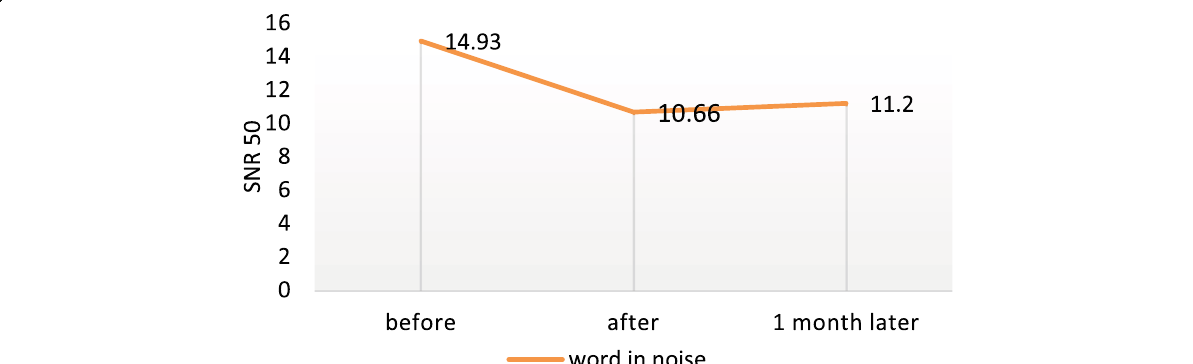
Fig. 3 The results of the repeated measures test showed that the mean score of “ Word in noise ” had a statistically significant difference in three measurements ( P .value < 0.05). The Tukey test showed that there was a statistically significant difference between the first score and the second score ( P .value < 0.05), while there is no statistically significant difference between the second score and the third score ( P .value <